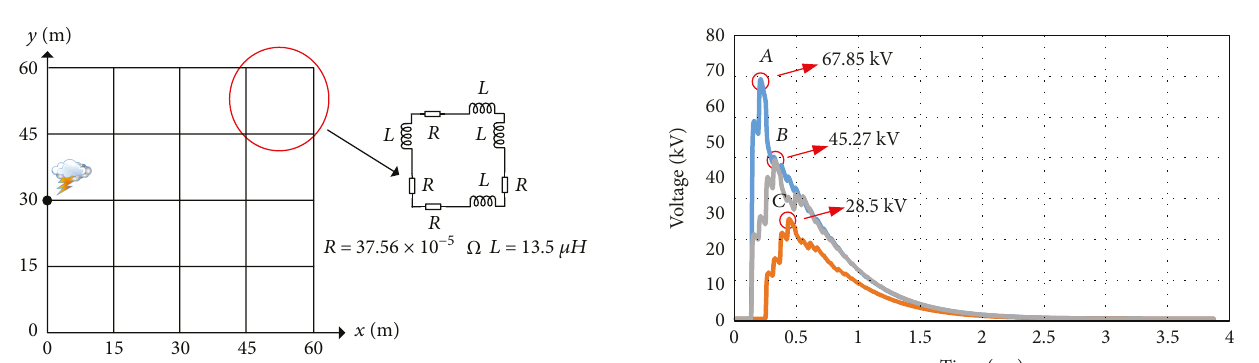
Figure 9: Ground potential rise at points A, B, and C after lightning in the regular ground grid.